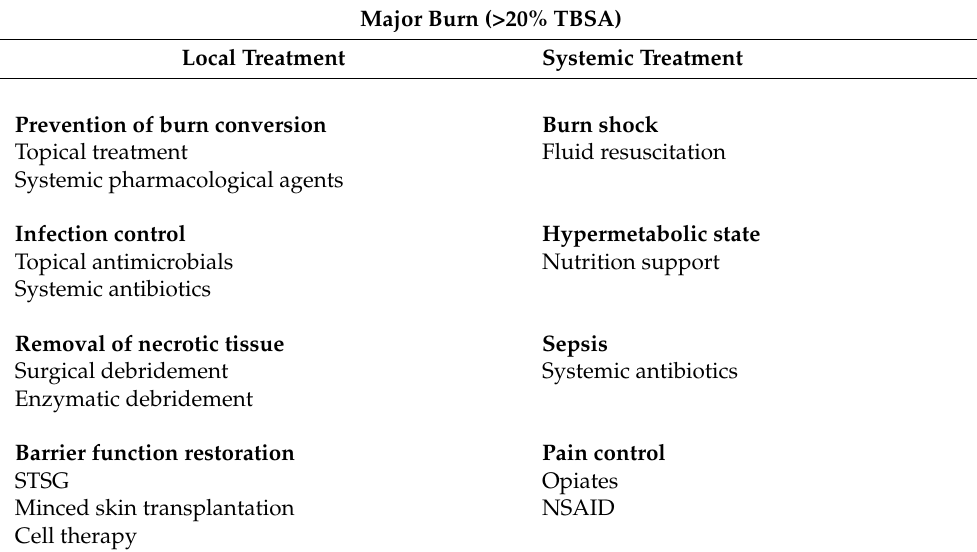
Table 2. Burn research has led to the development of novel treatment strategies in burn care. The prevention of burn wound progression with novel therapeutics, alternative methods to conventional split-thickness skin grafting (STSG) to provide wound coverage, as well as advancements in infection control, fluid resuscitation, pain management and nutritional support, has increased the survival rate and enhanced healing outcomes following severe burn